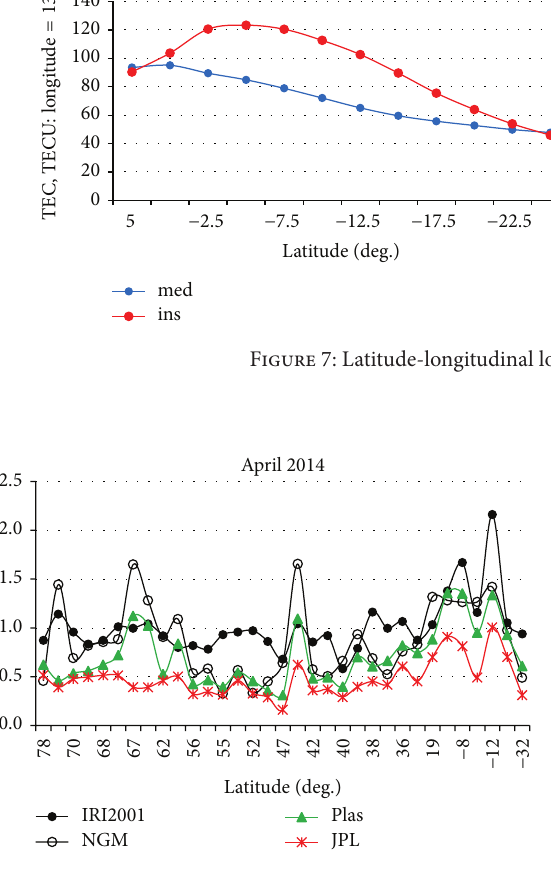
Figure 8: Comparison of absolute deviations of calculated foF2 values from observational ones for various models and at use of 𝜏 (med) for map